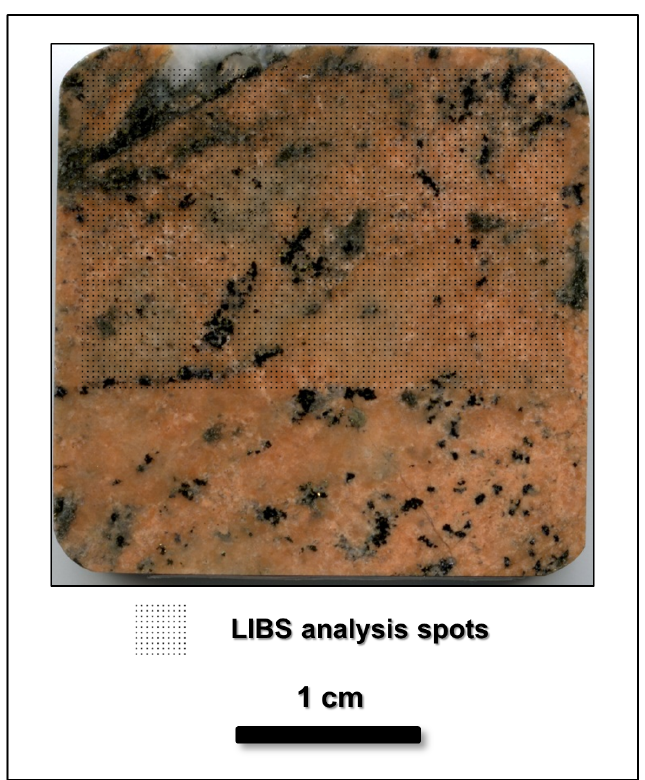
Figure 16. Configuration of LIBS analysis spots on each test sample. The upper 60% of each analysis line was used, for a total of 5429 LIBS analyses per sample.